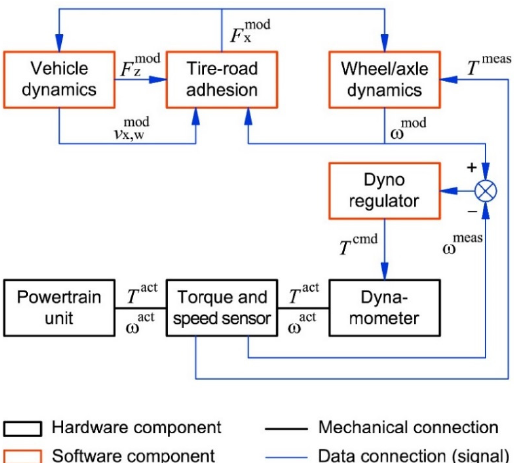
Figure 2. Hardware arrangement, simulation and control loops of a CiL system for powertrain testing with a vehicle model taking into account the tire slip.